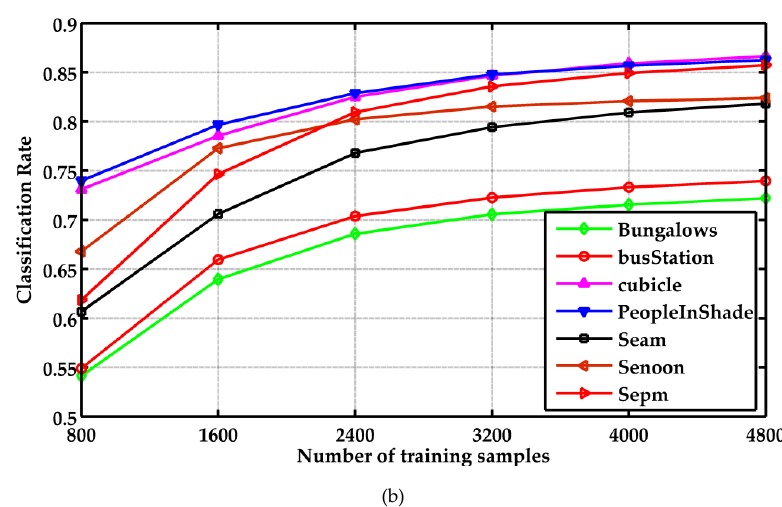
Figure 6. Classification rates of our method with different numbers of training samples on two datasets. ( a ) variation tendency on the popular dataset; ( b ) variation tendency on the large dataset.